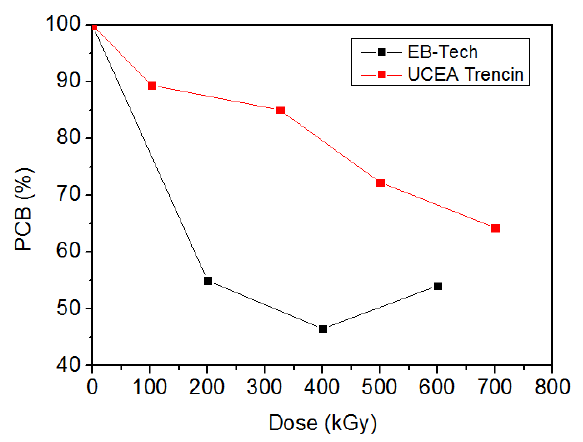
Figure 3. PCB concentration in soil sample as a function of dose irradiated by EB-Tech vs. UCEA